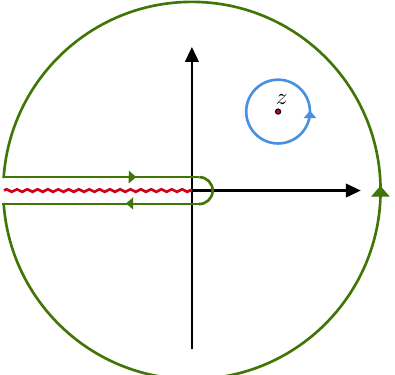
Figure 1 . The contour deformation used to derive the spectral function. We deform the blue contour centered around z into the green contour that runs along the branch cut with an arc at